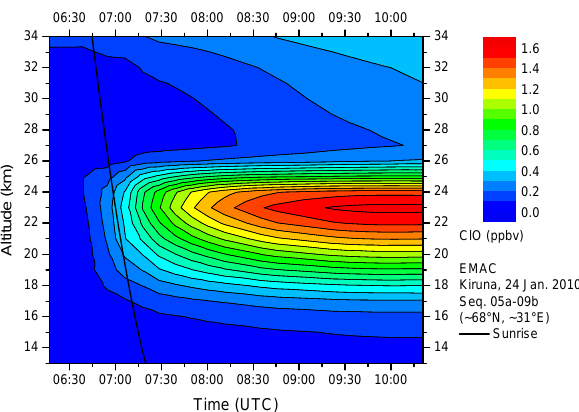
Fig. 5. Temporal evolution of ClO on 24 January 2010 as simulated by the chemical model EMAC. The build-up of ClO starts around sunrise. Maximum values of more than 1.6 ppbv are reached during daytime.